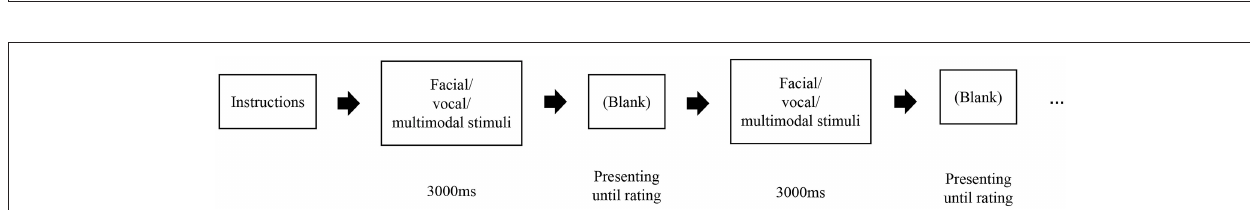
FIGURE 1 | Examples: photographs collected and used into Study 1 and Study 2 (high-, average- and low-attractive level from left to right). Participants have signed written informed consent for the publication of their face photographs.